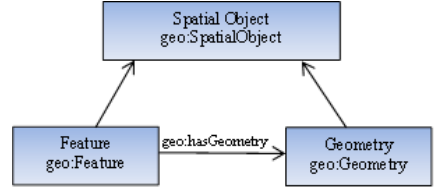
Figure.1. Main concepts and their relations in GeoSPARQL It uses two types of geometries; Geography Markup Language (geo:GML) and Well Known Text (geo:asWKT) for geospatial data.The geo:asWKT and geo:asGML properties link the geometry entities to the geometry literal representations. and gml:gmlLiteral data types respectively (Battle and Kolas, 2012). Furthermore, Simple Features, Egenhofer and